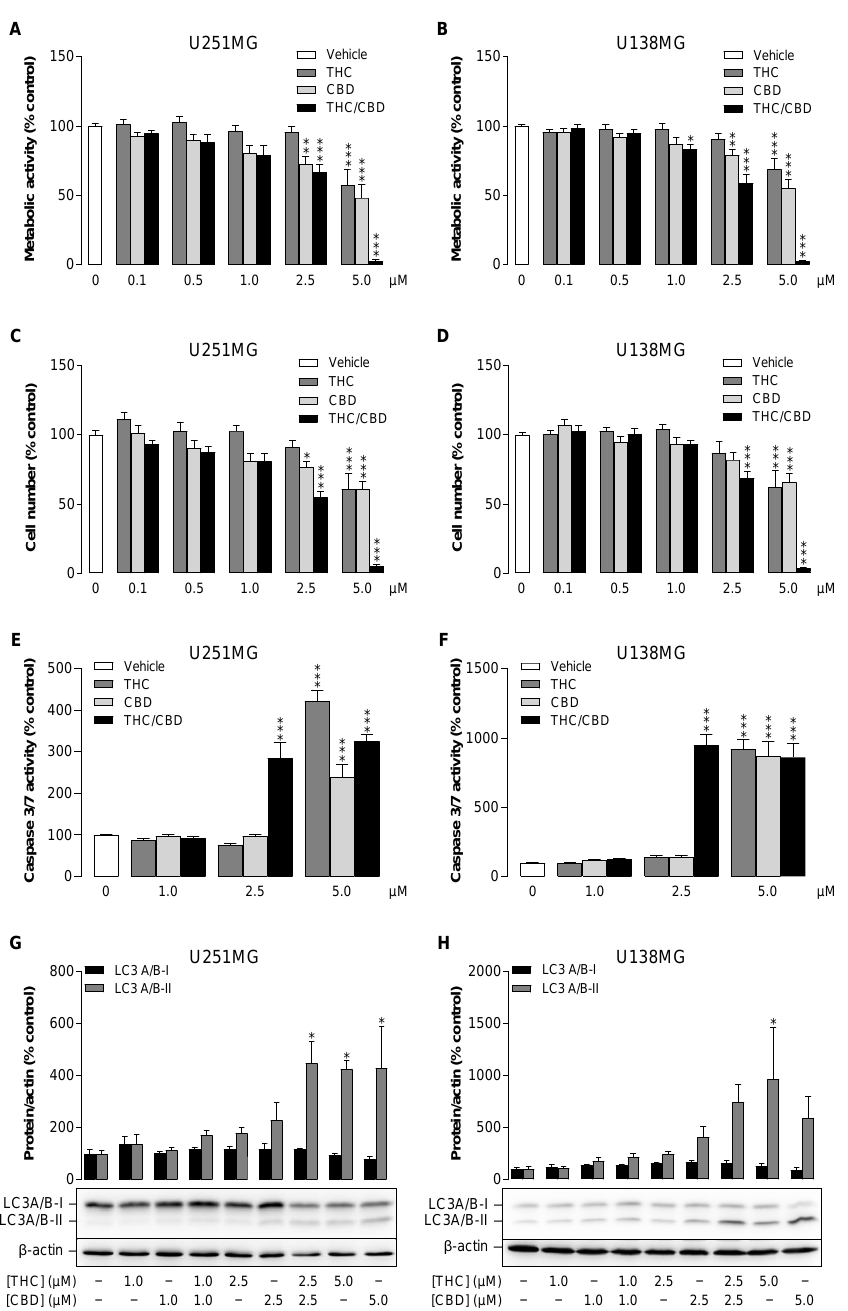
Figure 1. Influence of THC and CBD, administered alone or in combination, on metabolic activity, viability, apoptosis and autophagy in human glioblastoma cells. U251MG and U138MG cells were incubated for 24 h with selected concentrations of THC and CBD or their combination (in a ratio of 1:1) as well as vehicle control. Thereafter, metabolic activity was determined by WST-1 assay ( A , B ), cell number by crystal violet staining ( C , D ), caspase-3/-7 activity by ELISA ( E , F ) and LC3-I to LC3-II conversion by Western blot analysis ( G , H ). All percentage values shown refer to the vehicle control, which was set to 100%. The data represent mean values ± SEM of n = 10–12 (4 independent experiments in ( A – E )), n = 9 (3 independent experiments in F ) and n = 3 or n = 4 independent experiments in ( G , H ). * p ≤ 0.05, ** p ≤ 0.01, *** p ≤ 0.001 vs. corresponding vehicle control, one-way ANOVA with Dunnett’s post hoc test.